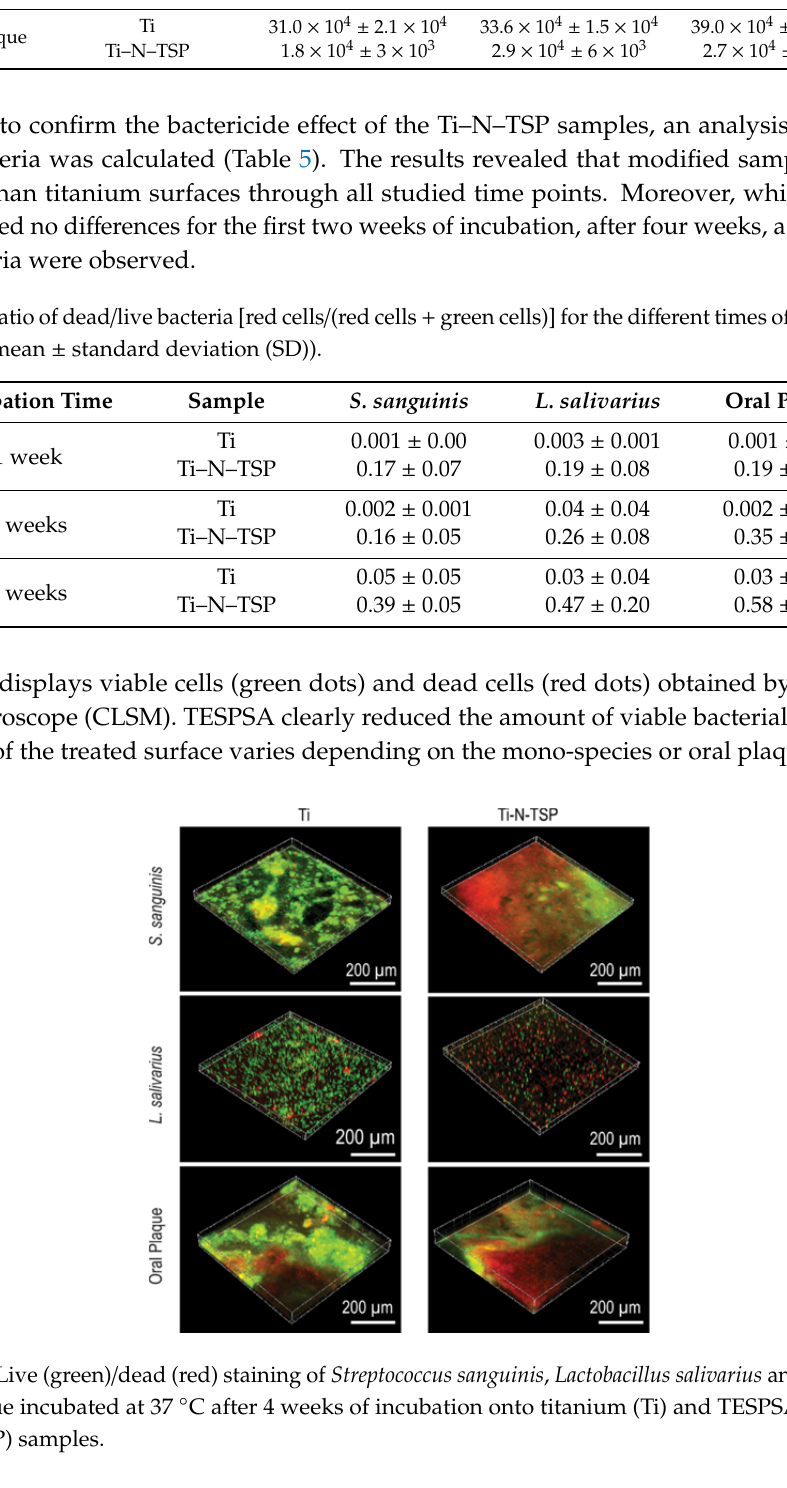
Table 4. Live bacteria of two bacteria strains ( Streptococcus sanguinis and Lactobacillus salivarius ) and complete oral plaque at 37 °C for 1, 2 and 4 weeks (mean ± standard deviation (SD)).